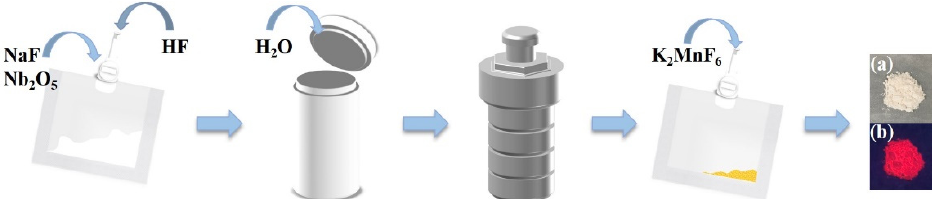
Figure 1. Schematic diagram of the experimental process for synthesizing NNOF:Mn 4+ red-emitting phosphors, and digital photographs of the phosphor under ( a ) visible light, ( b ) 365 nm UV